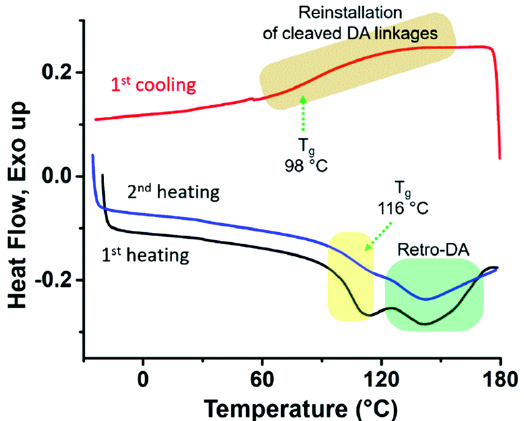
Figure 16. DSC traces illustrating retro-DA and DA reactions in a FMA-TFEMA-POSS hybrid. Re- produced from Polym. Chem . 2021, 12 , 876 – 884. [75] with permission from the Royal Society of produced from Polym. Chem . 2021, 12 , 876–884. Ref. [75] with permission from the Royal Society Chemistry. of